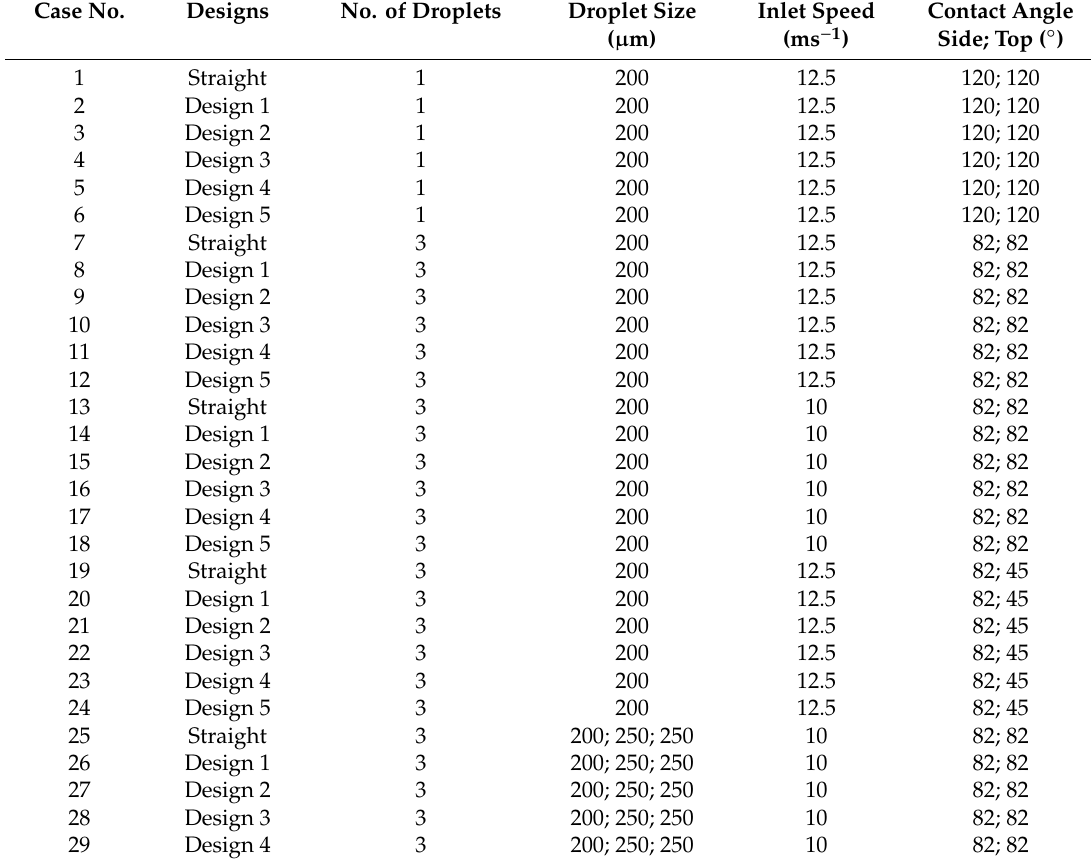
Table 2. Simulation cases under the same gas di ff usion layer (GDL) contact angle of 120 ◦ . Case No.